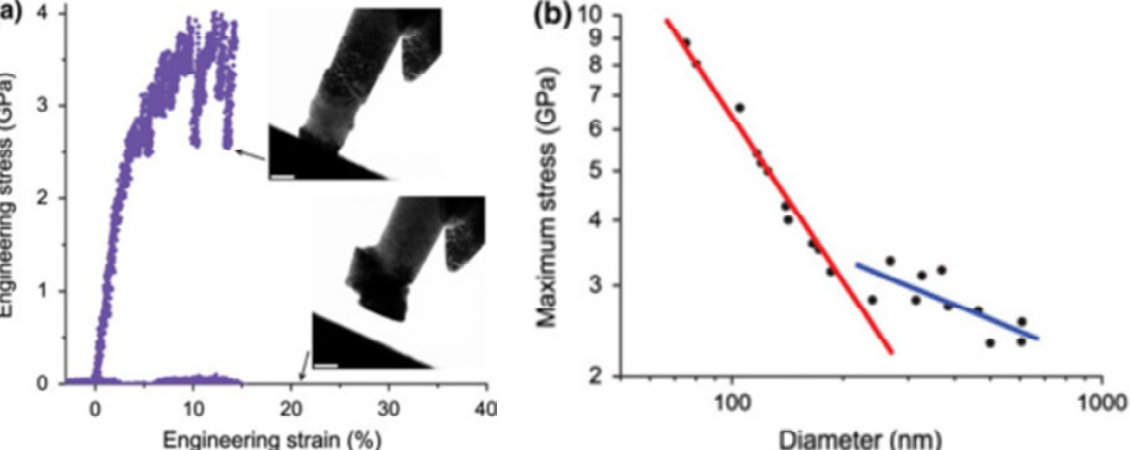
Fig. 30. (a) The typical engineering stress-strain curve for a 142 nm FIBed Mo single crystal. The insets are bright-ûeld TEM images taken before and after the dramatic strain burst. The scale bar represents 100 nm. (b) Maximum ûow stress plotted as a double-log function of pillar diameter D, representing two different strengthening exponent values, 1.0 and 0.29 for red and blue lines, respectively. Reprinted with permission from Shan ZW. 2012. In Situ TEM Investigation of the Mechanical Behavior of Micronanoscaled Metal Pillars. JOM 64, [105]: © 2012 Springer International Publishing